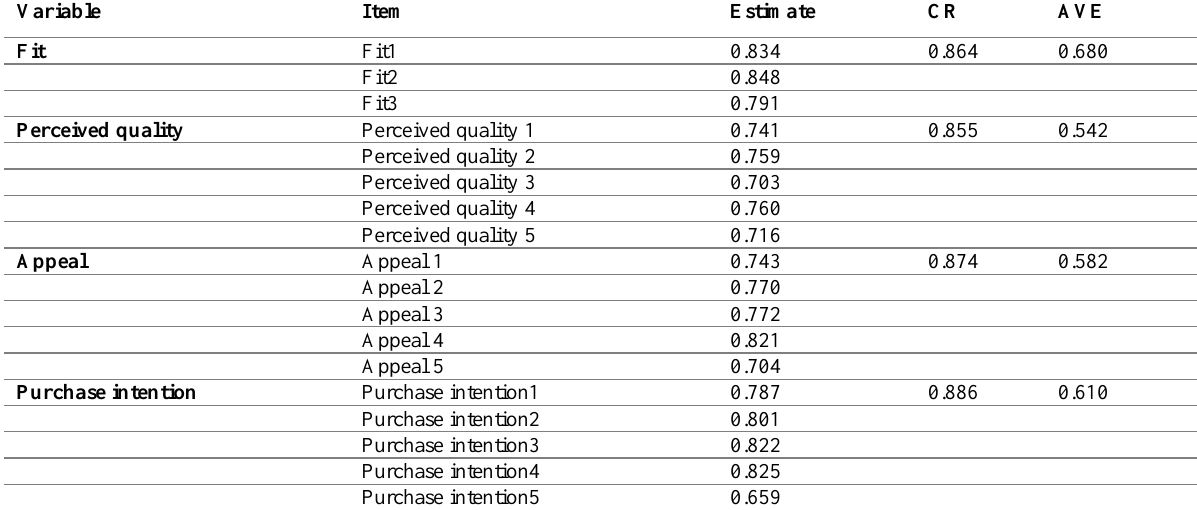
Table 6: Convergent